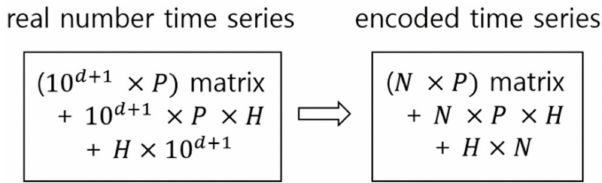
Figure 1. Complexity reduction in pattern learning through encoding the real number data. N is the base number of encoding ( baseN ), which is the size of a targeted symbol set; d is the number of digits of concern after the decimal point; P is the size of projection layer; and H is the size of hidden